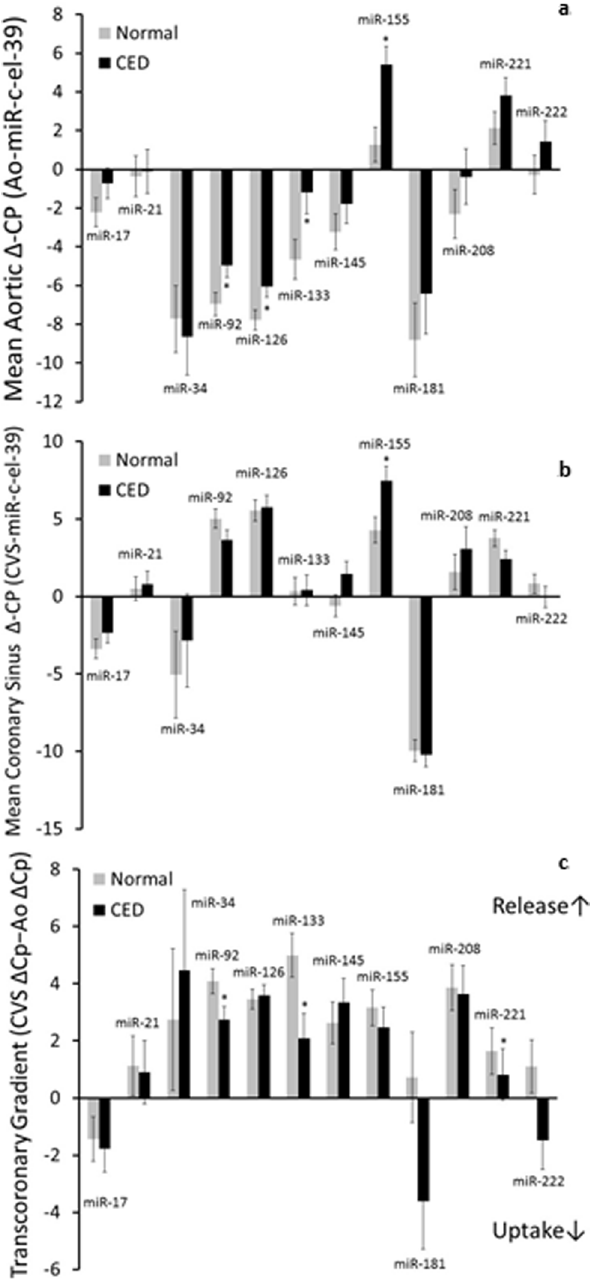
Figure 1. Transcoronary gradients normalized using the delta Cp method, in patients with normal coronary endothelial function and those with CED with regard to endothelial-related miRs (A), myocardial-related miRs (B), and vascular/inflamma- tory miRs (C). The transcoronary gradients of miR-92a (A) and miR-133 (B) were significantly elevated in patients with CED compared to those with normal coronary endothelial function (*, p , 0.05).